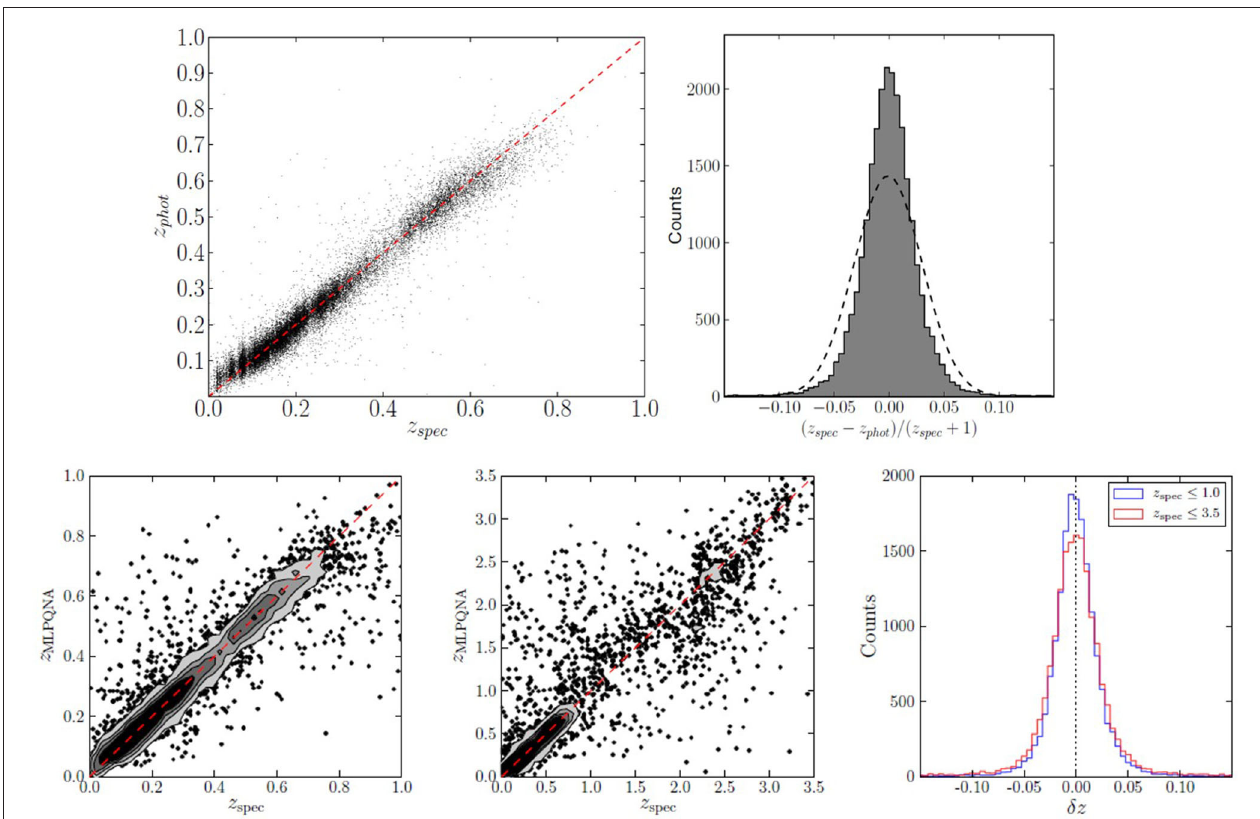
FIGURE 3 | Merged diagrams from Cavuoti et al. (2015) and de Jong et al. (2017). Upper panels: Photo-z results obtained with KiDS DR2 data. In the right diagram, the dashed line represents the Gaussian fit to the residual distribution. Lower panels: Results of photo-z experiments with KiDS DR3 data. The left and central panels are the scatter plots for the experiments limiting the spectroscopic redshifts, respectively, to 1 and 3.5. On the right, the superimposed histograms of the residual distributions for the two cases are